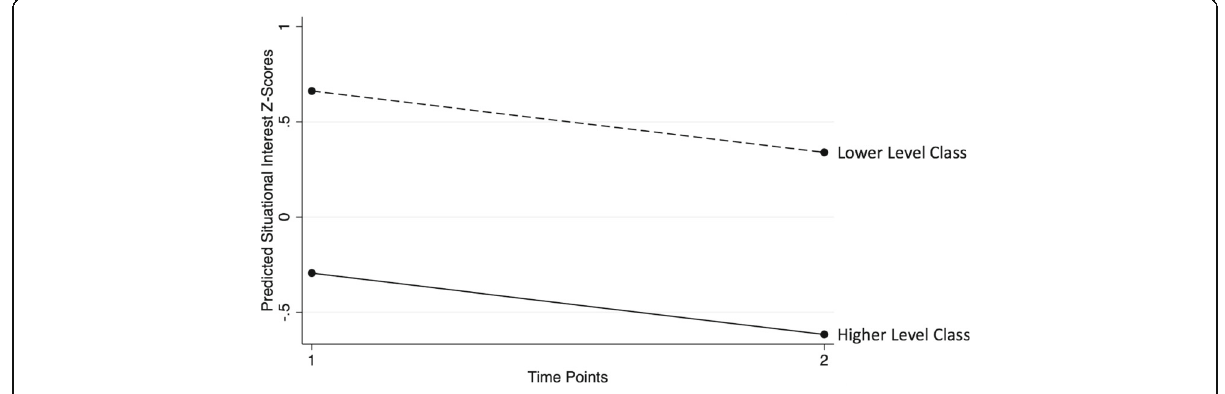
Fig. 3 Predicted situational interest trajectories, by class level